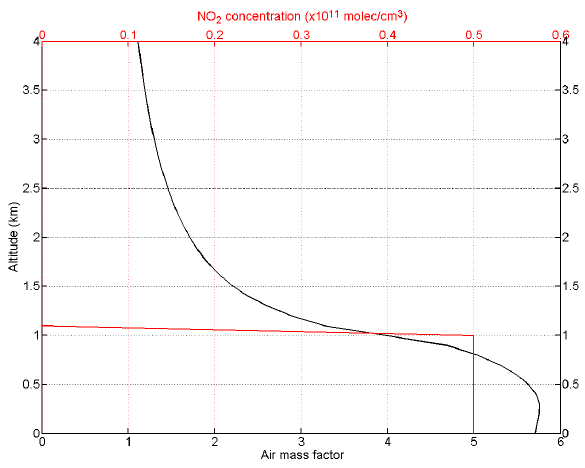
Fig. 6. Air mass factor versus altitude (black) for an idealized NO 2 tropospheric profile (red) well mixed in the boundary layer and of negligible concentration in the free troposphere. The calculations were done at 460nm, setting an albedo of 0.1, a relative azimuth and solar zenith angle of 90 and 45 ◦ , respectively, and a surface visibility of